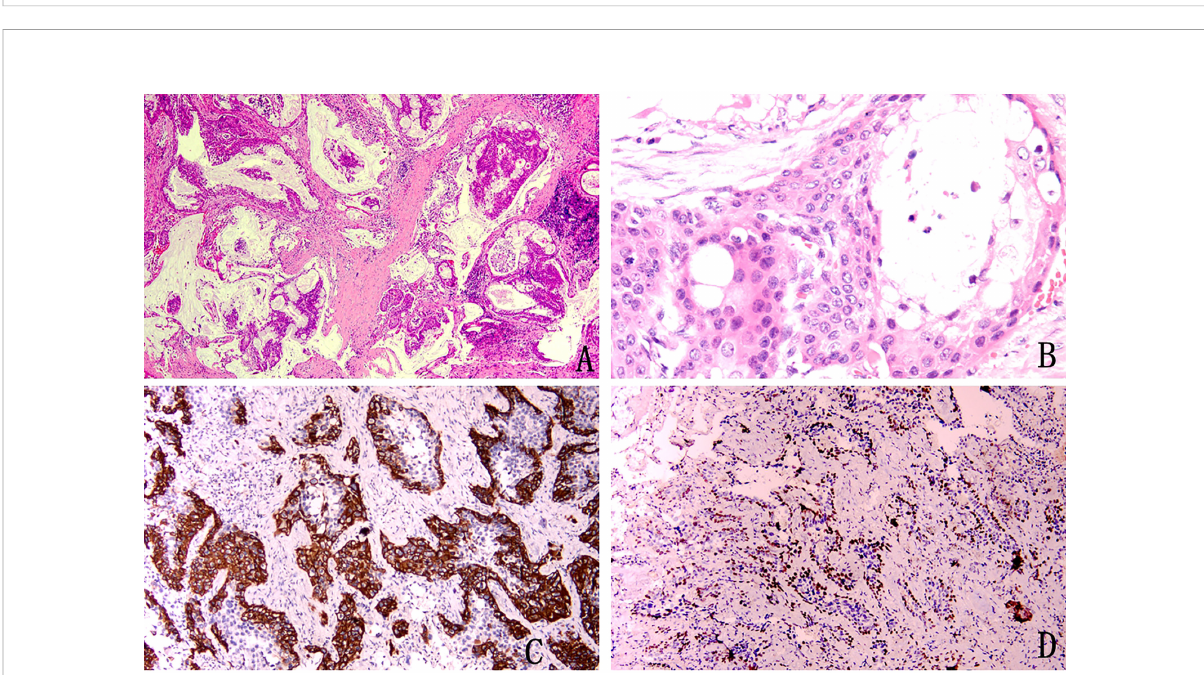
FIGURE 2 Pathological image of high-grade mucoepidermoid carcinoma (A) Squamous epithelium and mucus-rich columnar epithelium can be seen at low magni fi cation (H&E stain, magni fi cation × 40). (B) Squamous cells distributed in patches, columnar cells with mucus inside and outside the cells, and intermediate cells with eosinophilic cytoplasm (H&E stain, magni fi cation × 400). (C) Immunohistochemical staining for CK5/6 was positive (magni fi cation × 100). (D) Immunohistochemical staining was partially positive for P40 (magni fi cation ×